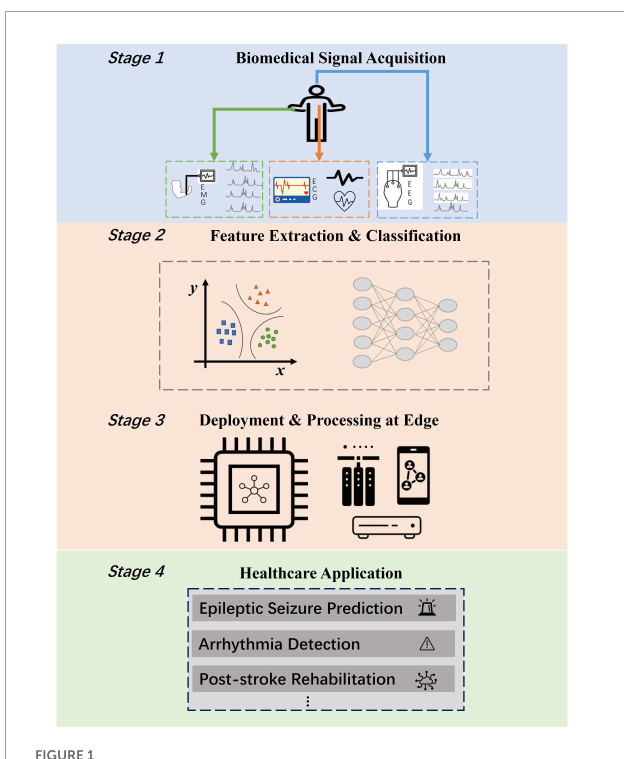
FIGURE1 Edge computing scenarios for biomedical applications including four stages. The bottleneck lies in the realization of energy efficient feature extraction and classification approach (Stage 2) for deployment at edge (Stage